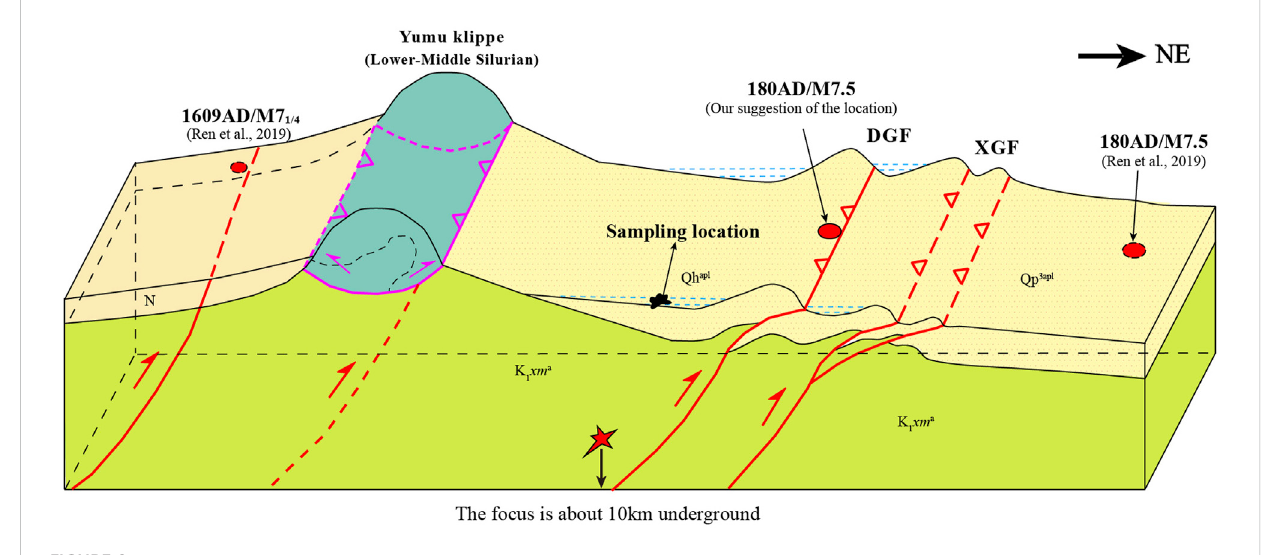
FIGURE 9 Structural model for the formation of the Dagengzi and Xiaogengzi faults and the 180AD/Ms7.5 Biaoshi earthquake, showing the northward expanding of the thrust faulting and growth of the plateau. DGF, Dagengzi Fault; XGF, Xiaogengzi Fault. Qp 3apl , alluvial – pluvial deposits of Upper Pleistocene; Qh apl , Holocene alluvial – pluvial